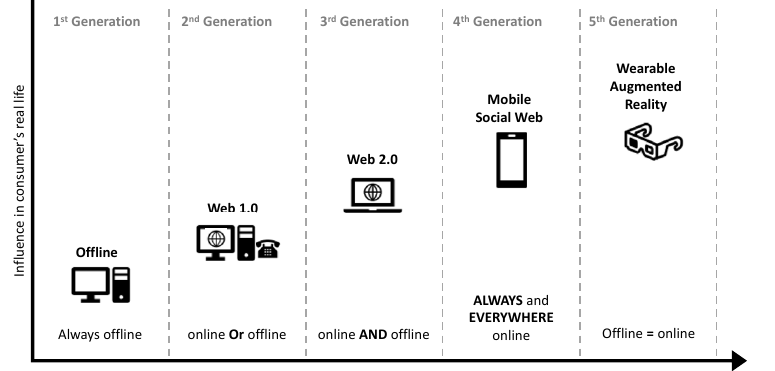
Fig. 1. Evolution of media devices